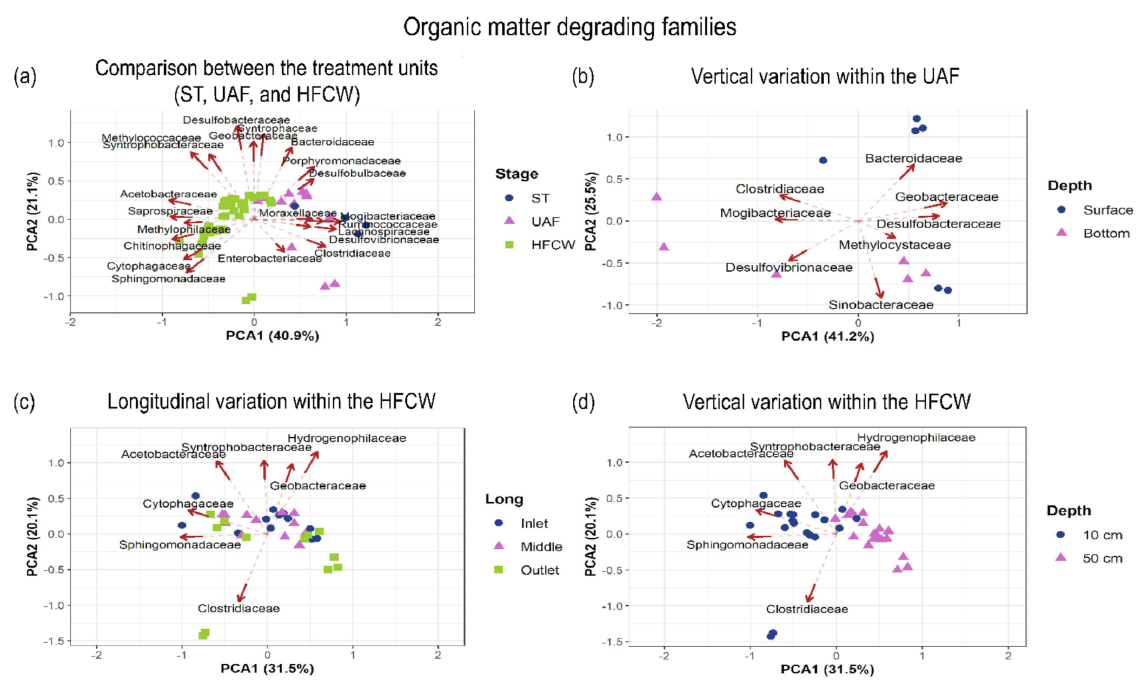
Figure 8. Biplots for organic matter degrading families ( a ) Comparison between the treatment units (ST, UAF, and HFCW), ( b ) Vertical variation within the UAF, ( c ) Longitudinal variation within the HFCW, ( d ) Vertical variation within the HFCW. For illustration purposes, only the families that appear in the discussion are